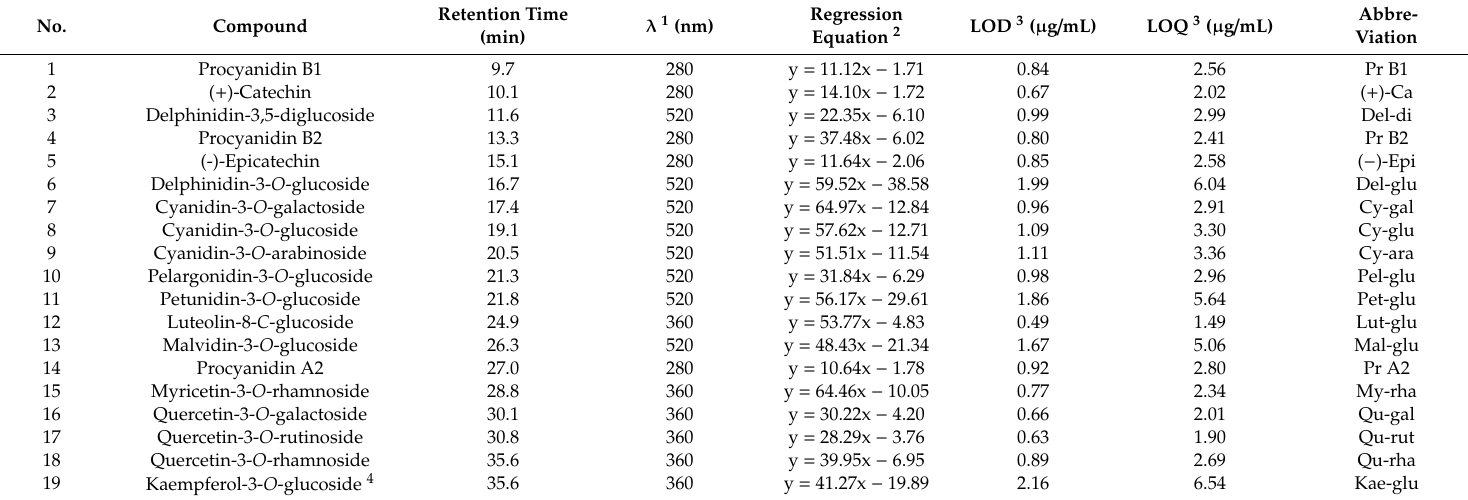
Table 1. Retention time, wavelength ( λ ), regression equation, limit of detection (LOD), and limit of quantification (LOQ) during HPLC-UV of flavonoid standards.